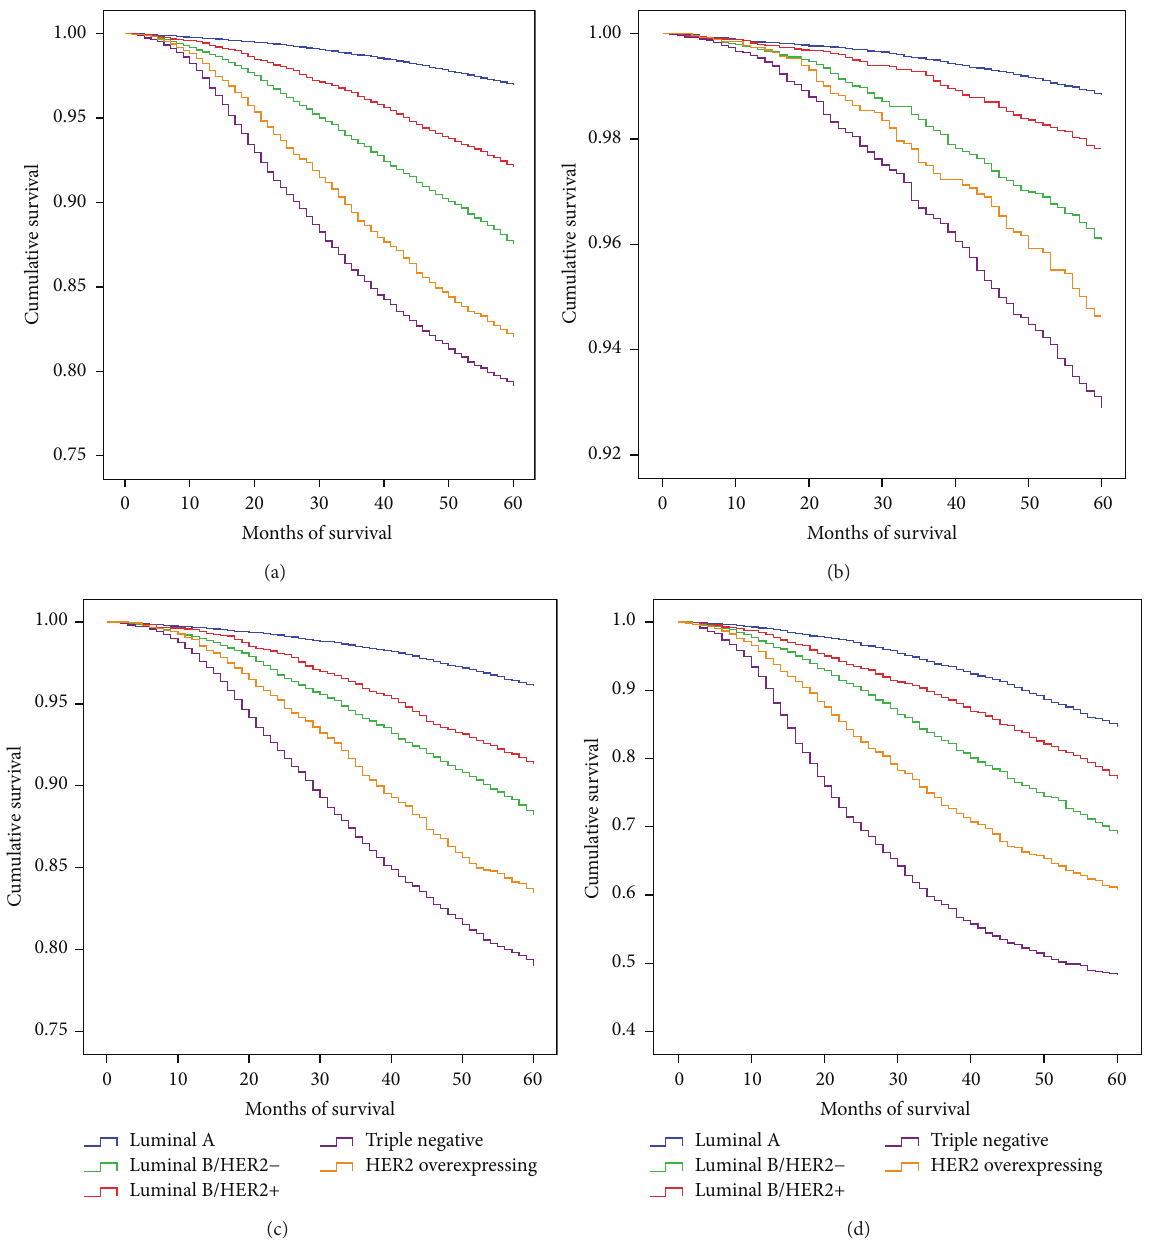
Figure 2: Kaplan Meier 5-year survival for the IHC surrogate classification subtypes for all stages combined (a), stage 1 (b), stage 2 (c), and stage 3